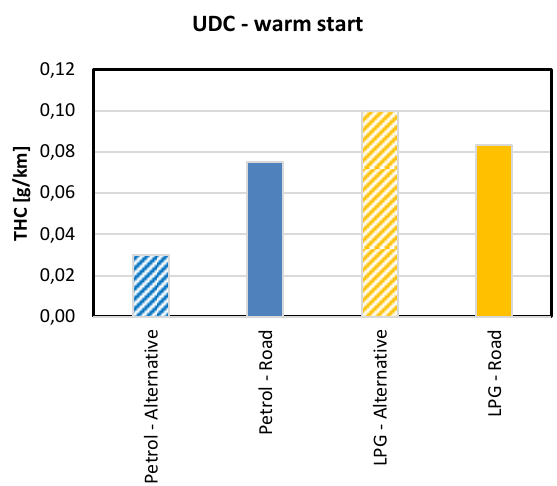
Fig. 7. Impact of resistance forces on THC emissions for UDC phase